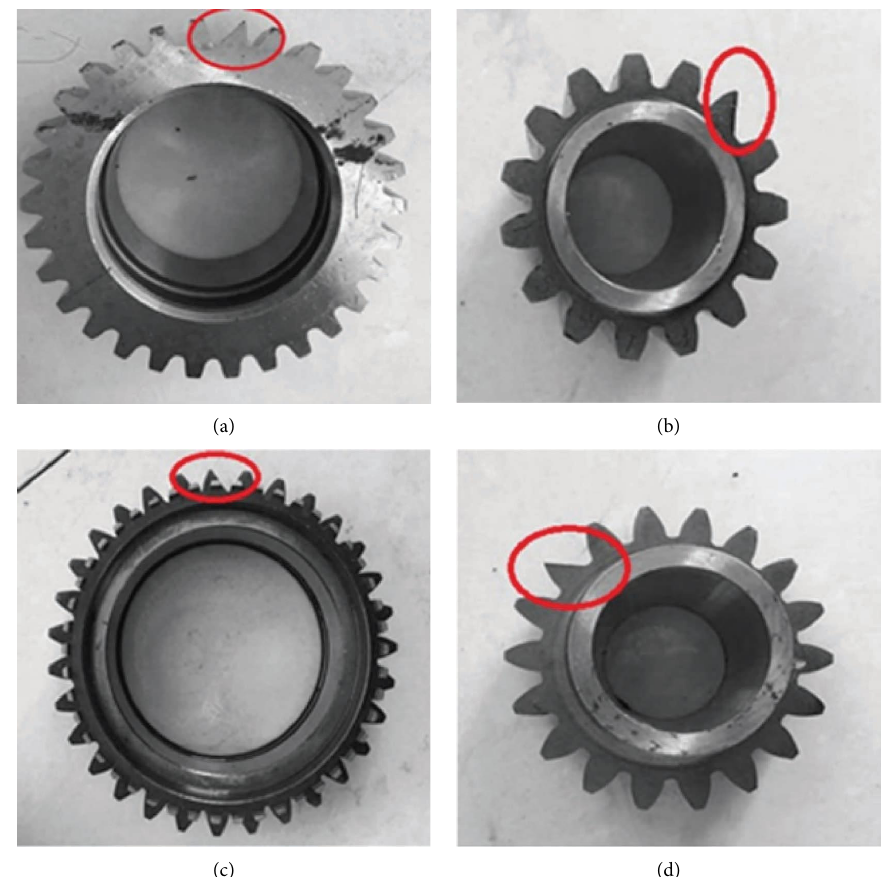
Figure 10: Planetary gearbox fault-type setting (teeth broken): (a) sun gear Z � 30, (b) planetary gear Z � 15, (c) sun gear Z � 31, and (d) planetary gear Z �